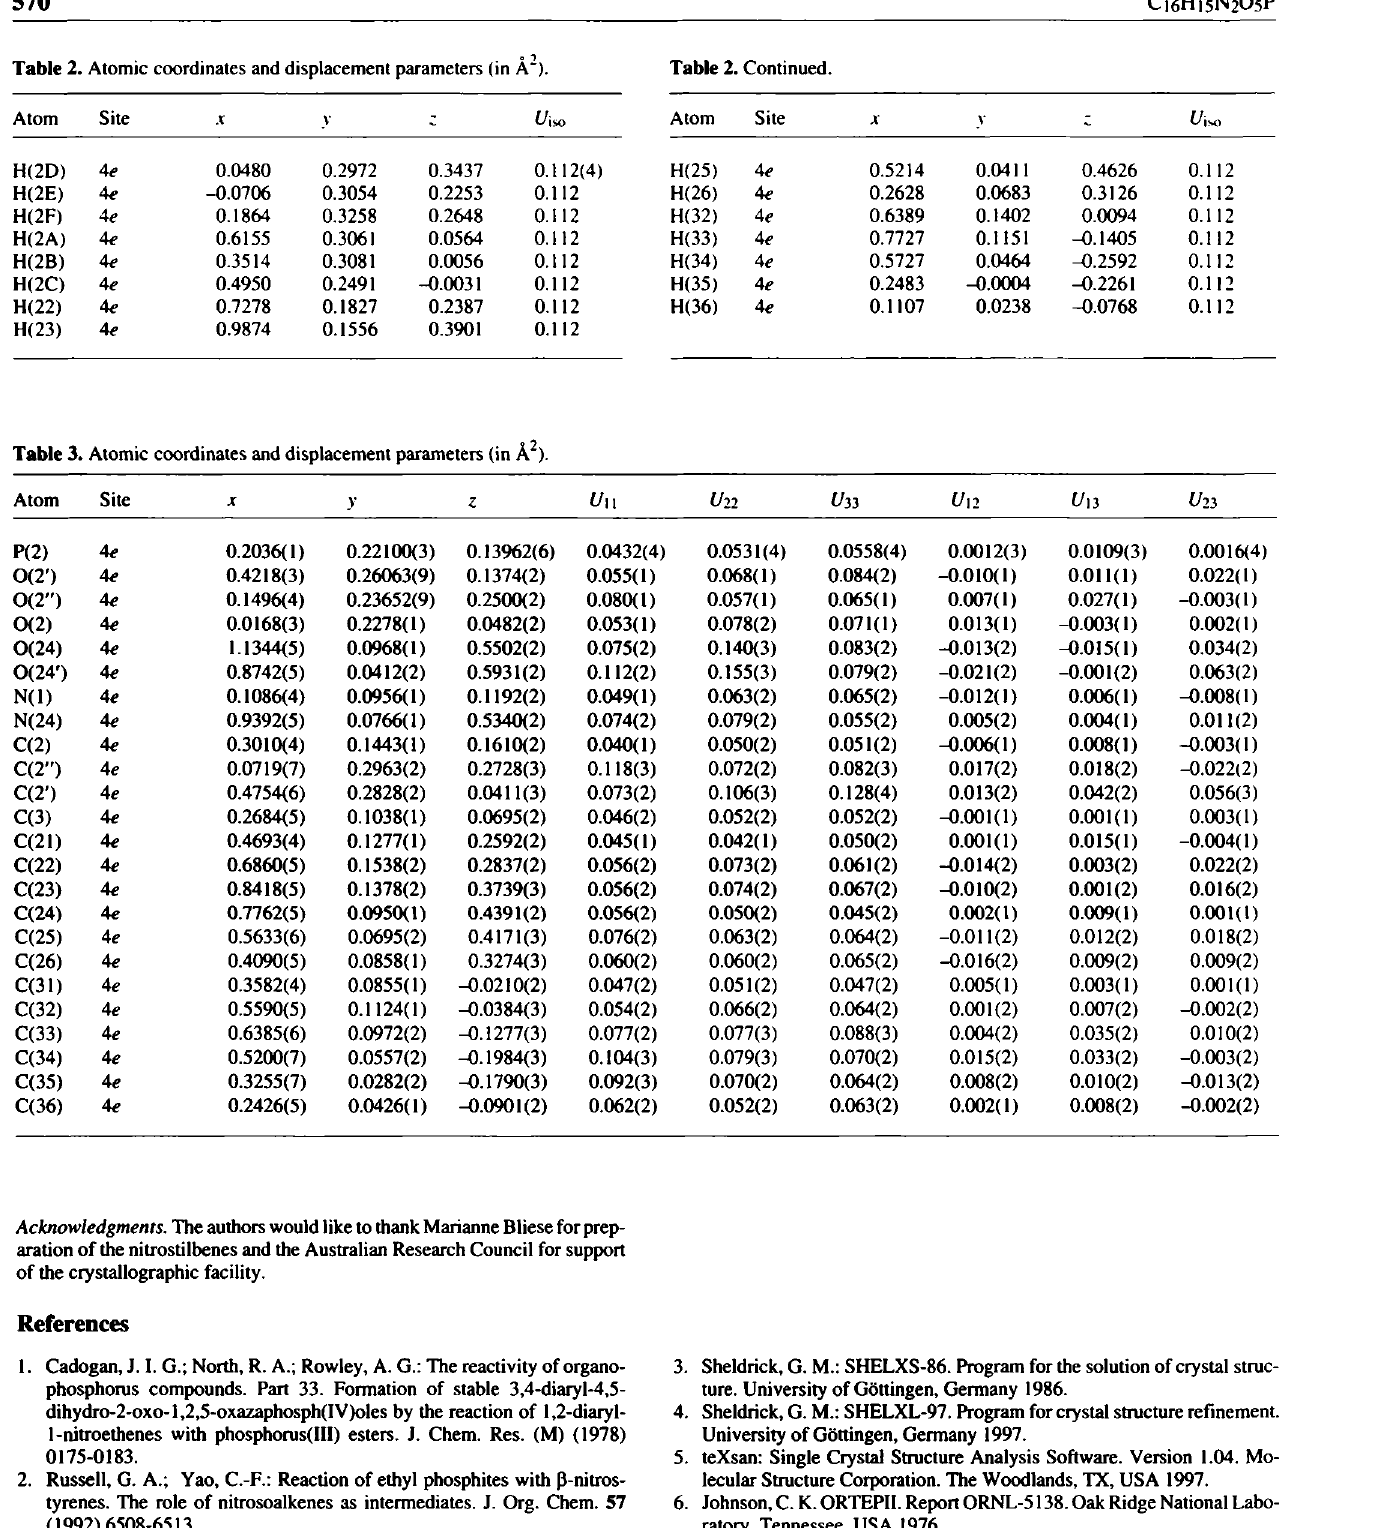
Table 3. Atomic coordinates and displacement parameters (in A 2